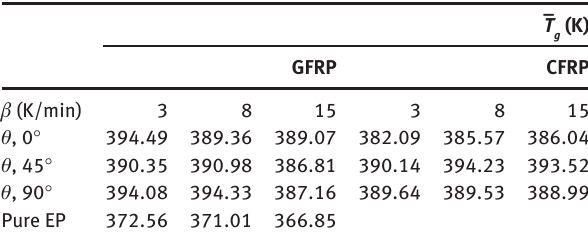
Table 6: Reference temperatures for the investigated